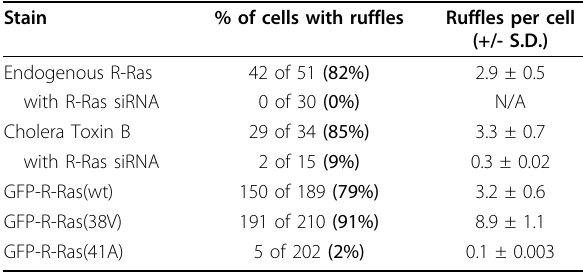
Table 1 Ruffle Summary